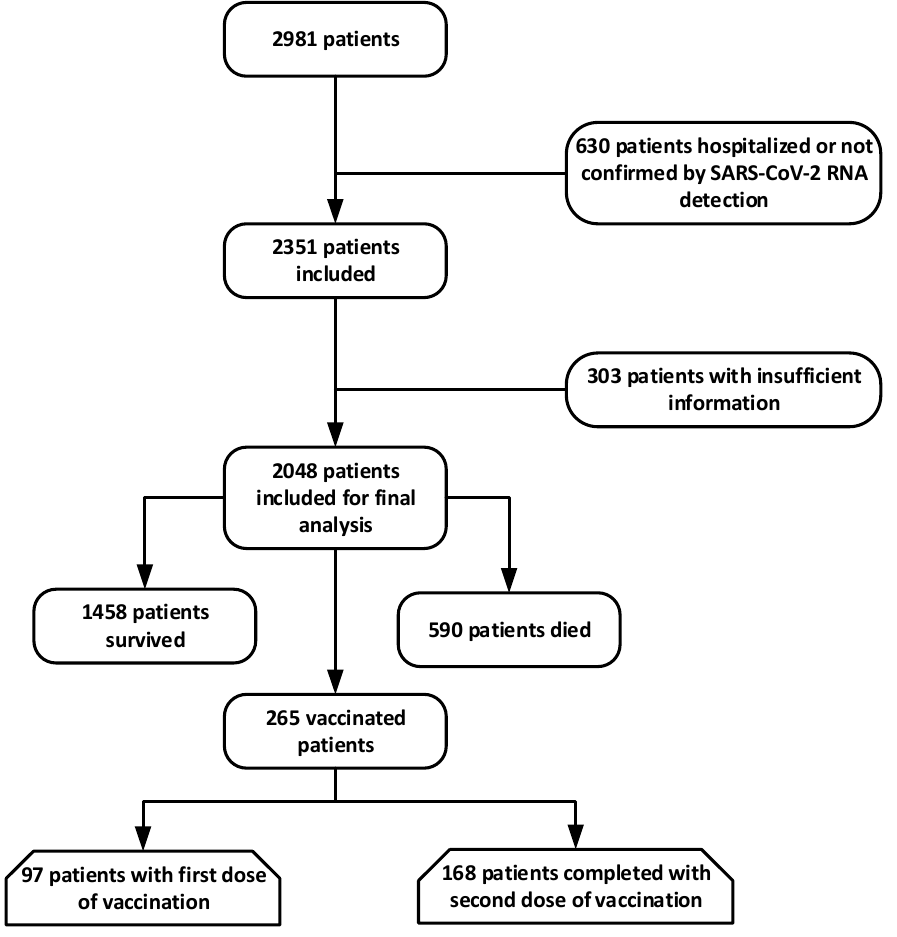
Figure 1. Patient’s selection flow chart.